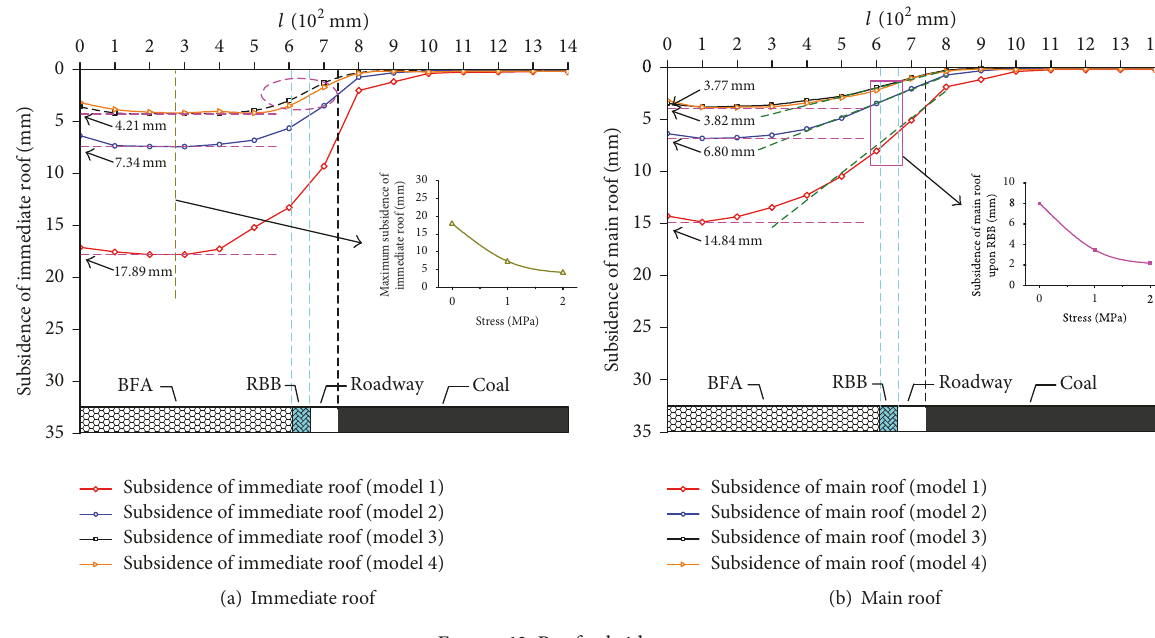
Figure 12: Roof subsidence